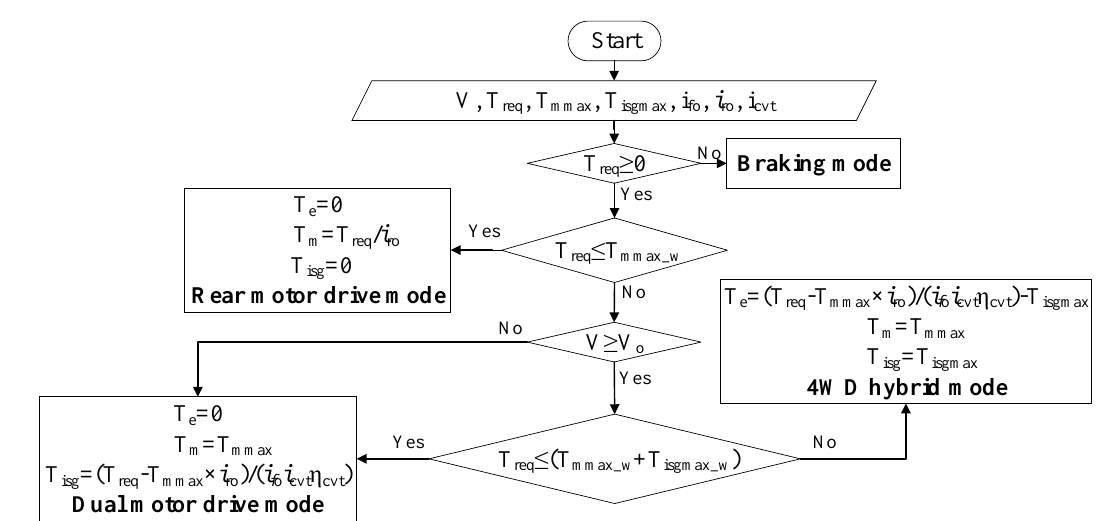
Figure 5. Control strategy in charge depleting (CD) mode.